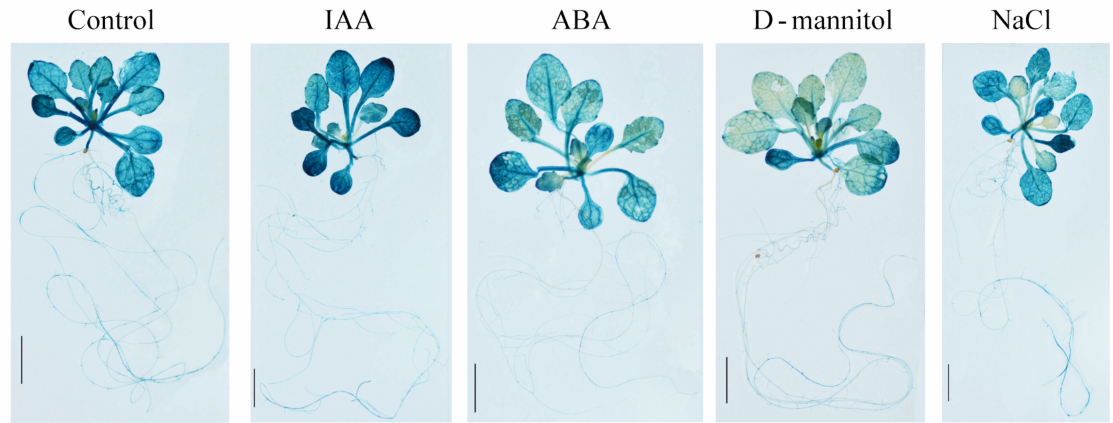
Figure 11. Three-week-old ProGASA15::GUS transgenic Arabidopsis seedlings growing on 1/2 MS AGAR plates were transplanted into medium without or containing 300 mM mannitol, 150 mM NaCl, 20 µ M ABA, 20 mg/L IAA,